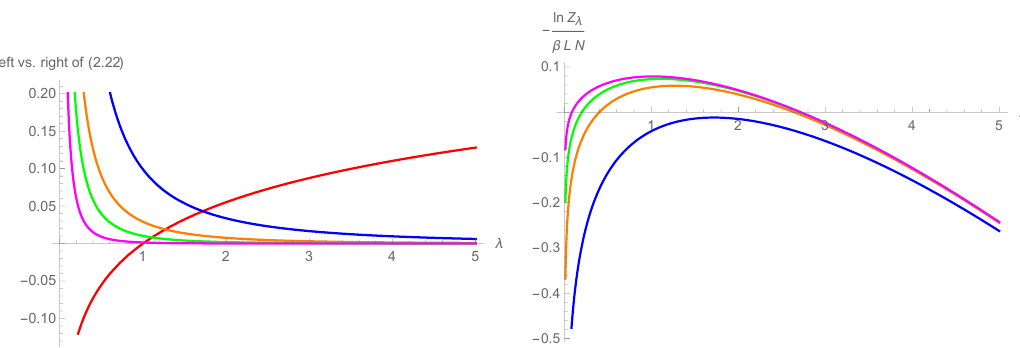
Figure 1 . Left panel: a graphic solution of eq. (2.24) for L = 1 and (cid:12) = 1 ; 2 ; 3 ; 5, top to bottom, all measured in the unit of 1 = (cid:3) 2 . The left-hand side of eq. (2.24) is shown in red and the right-hand sides are shown in blue (top), orange, green, and magenta, respectively. Right panel: the pseudo free energy normalized by N times length L as a function of (cid:21) . (cid:12) = 1 ; 2 ; 3 ; 5, from the bottom to the top. The real free energy is the maximum along the real axis of (cid:21)